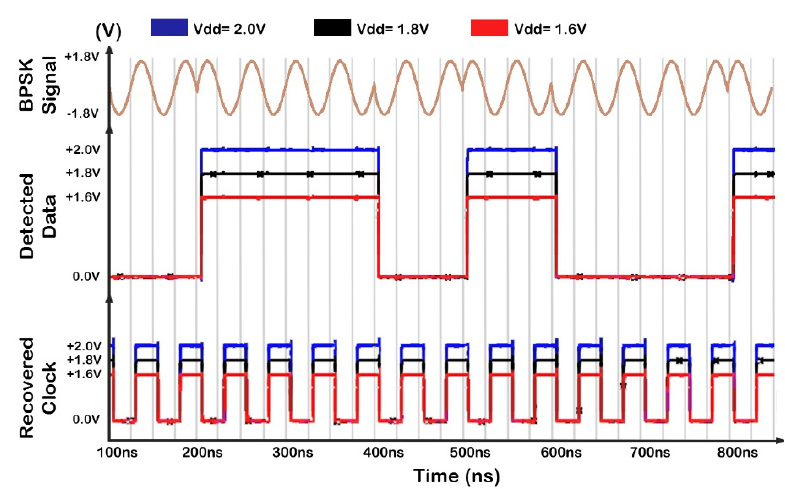
± 10% V dd variation.